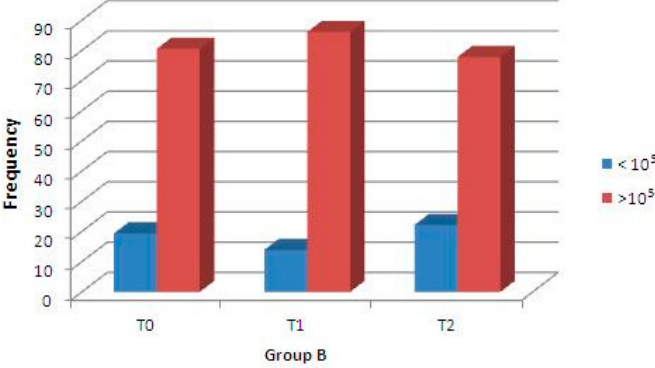
Figure 4. Percentage of Group A samples in relation to density changes of S. mutans (CFU/mL) at baseline (T0), after 7 days (T1), and after 14 days (T2). A regression binary logistic analysis showed a significant difference ( p < 0.001) between T0 and T1, and between T0 and T2. Molecules 2016 , 21 , 1008 Table 1. Percentage of samples containing a high density of Streptococcus mutans CFU ( ≥ 10 5 CFU/mL). Percentage of Samples Containing High S. mutans Density Time